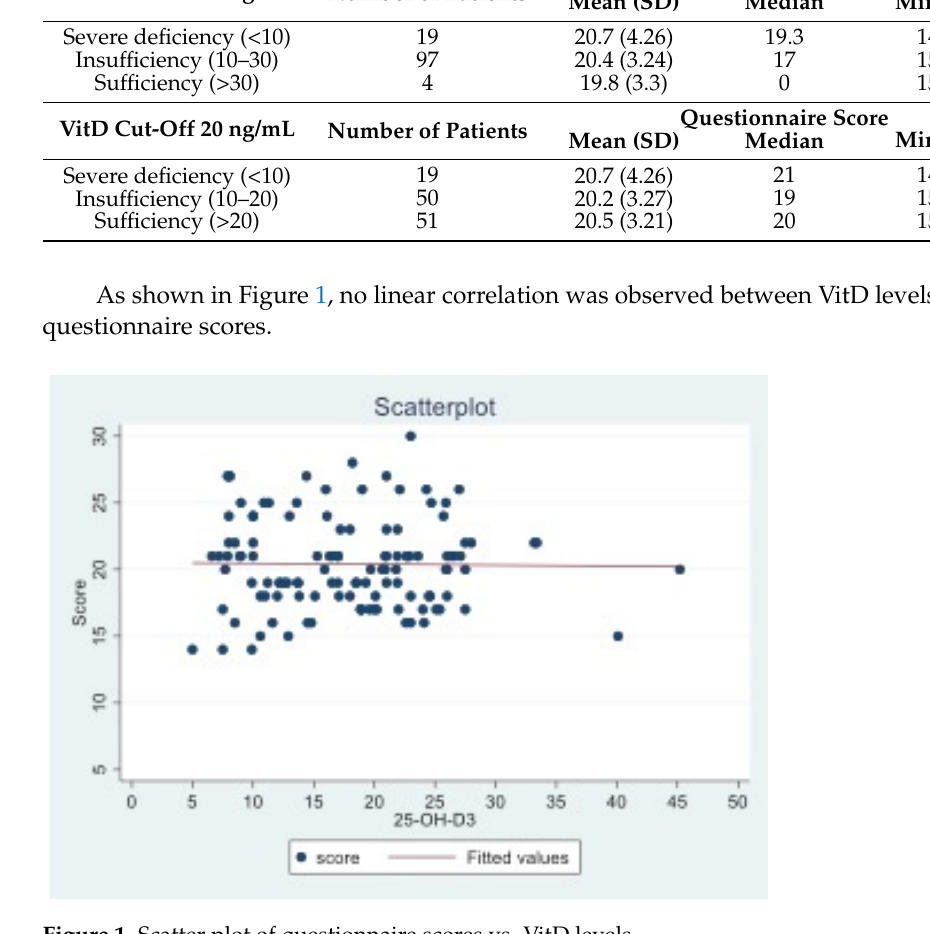
Figure 1. Scatter plot of questionnaire scores vs. VitD levels.